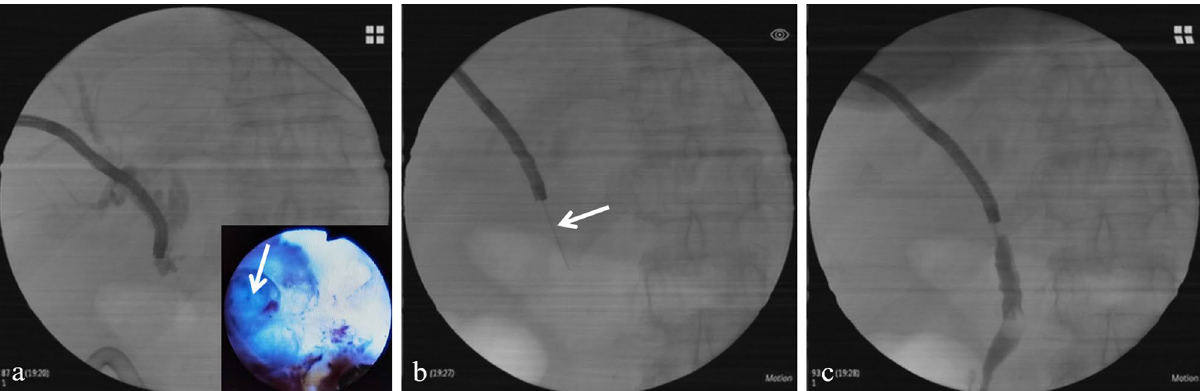
Figure 3. PTCS-assisted puncture of the complete biliary anastomotic strictures using the hard tip of the guidewire. ( a ) The bilio-biliary anastomosis is an eccentric occlusion (arrow) under PTCS; although contrast agent was injected, the distal duct does not become visible. ( b ) Hard-tip puncture (arrow) of the stricture is conducted under PTCS. ( c ) Recanalization is confirmed by the visible distal duct through radiography. PTCS percutaneous transhepatic